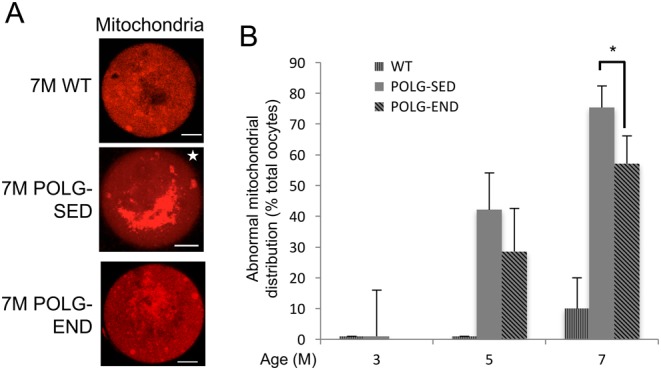
Exercise maintains normal mitochondrial distribution in oocytes from POLG mice at 7 months of age. (A) Representative images of MII eggs labeled with MitoTracker (shown in red) from 7-month-old (7 M) WT, POLG-sedentary (POLG-SED), and POLG endurance exercised (POLG-END) mice (mitochondrial staining with MitoTracker shown in red). Star indicates abnormal mitochondrial patterning; scale bar = 15 μm. (B) Occurrence of abnormal mitochondrial distribution in MII oocytes of WT, POLG-SED and POLG-END mice (mean shown, error calculated as s.d. of a binomial distribution; n = 20–49 oocytes from 5–6 mice per group; *P < 0.05).